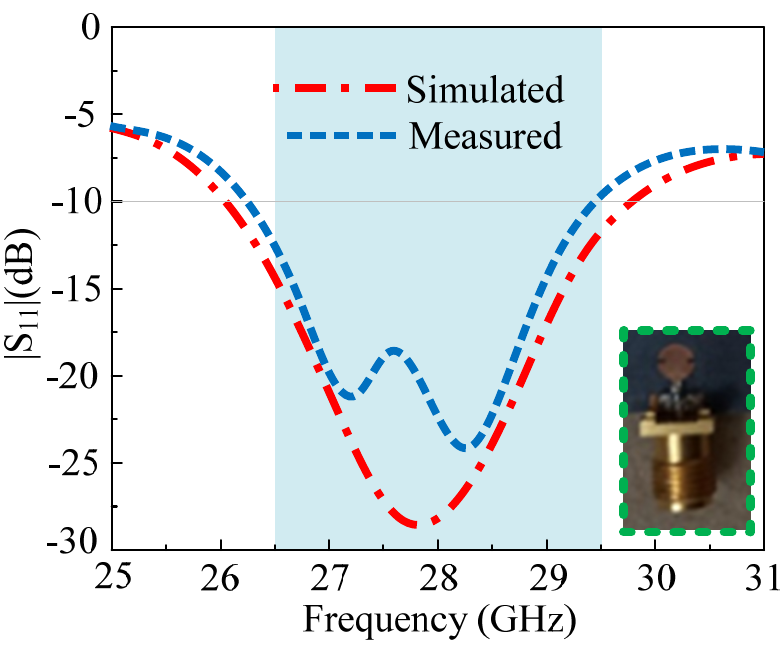
Figure 3. Simulated and Measured S-Parameter of proposed single element antenna.